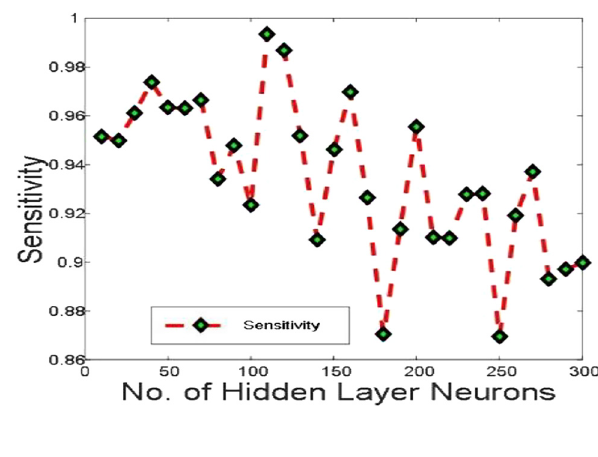
Figure 10: Sensitivity